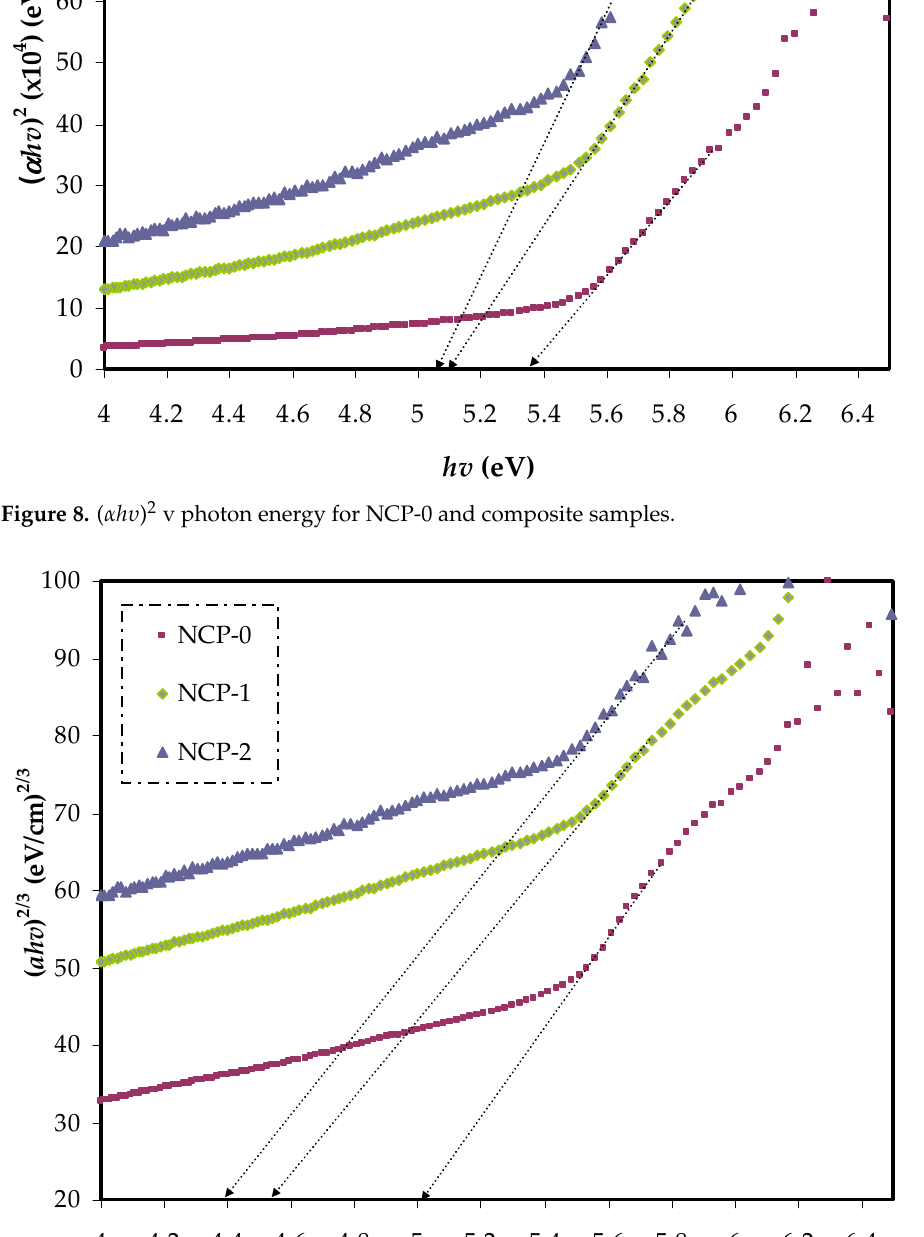
Figure 10. ( α h υ ) 1/2 v photon energy for NCP-0 and composite samples.